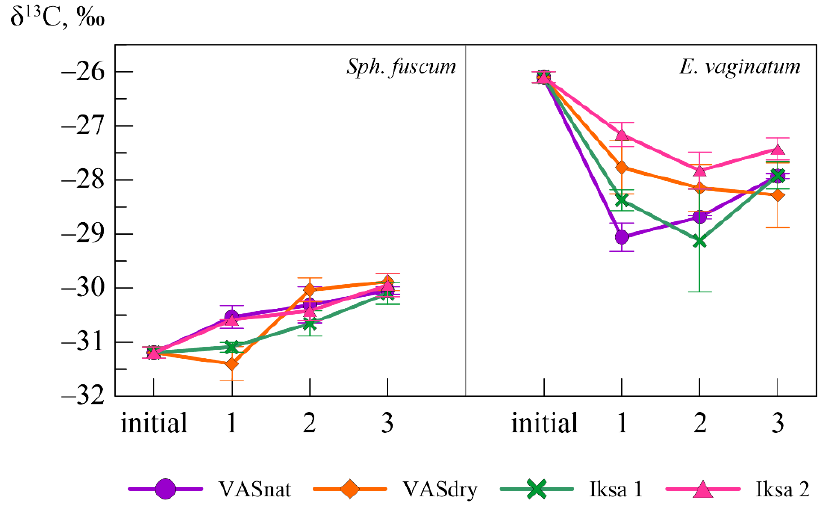
Figure 5. Variability of the carbon isotope composition of peat-forming plants during the biochem- ical transformation.